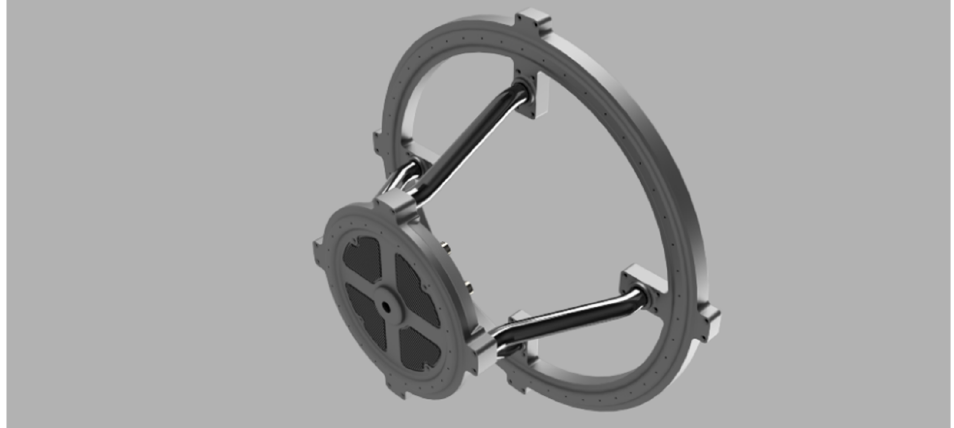
Figure 5. The designed prototype of a hemisphere-shaped acoustic camera ( Acoustic Camera 1 ).